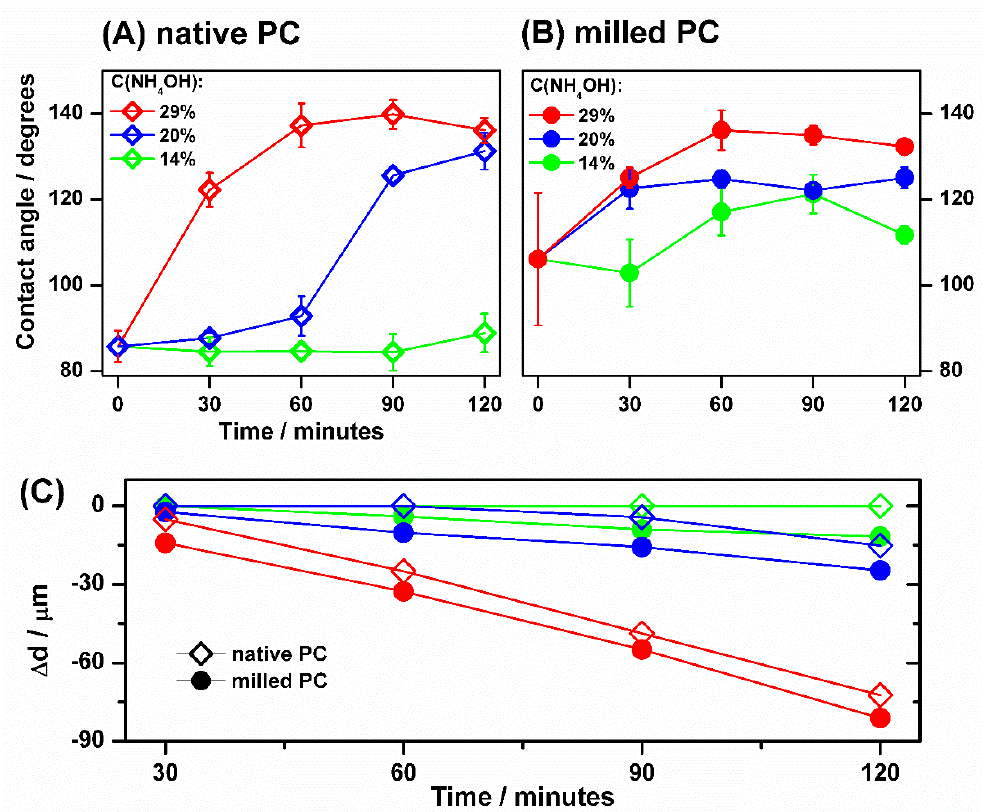
Figure 2. Contact angle of water on polycarbonate modified in ammonia solution with various concentrations (14—green, 20—blue and 29%—red) in the function of time of exposure for native PC ( A , diamonds) and completely milled PC slabs ( B , circles). The values of the contact angle are the averages of three measurements. ( C ) Effect of the ammonia solution concentration and duration of modification of native PC (diamonds) and completely milled PC slabs (circles) in the function of thickness of removed layer of PC surface.